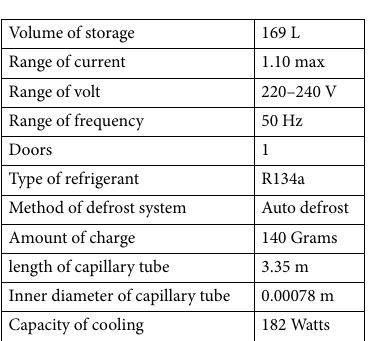
Table 1. Technical parameters of a Household refrigerator.